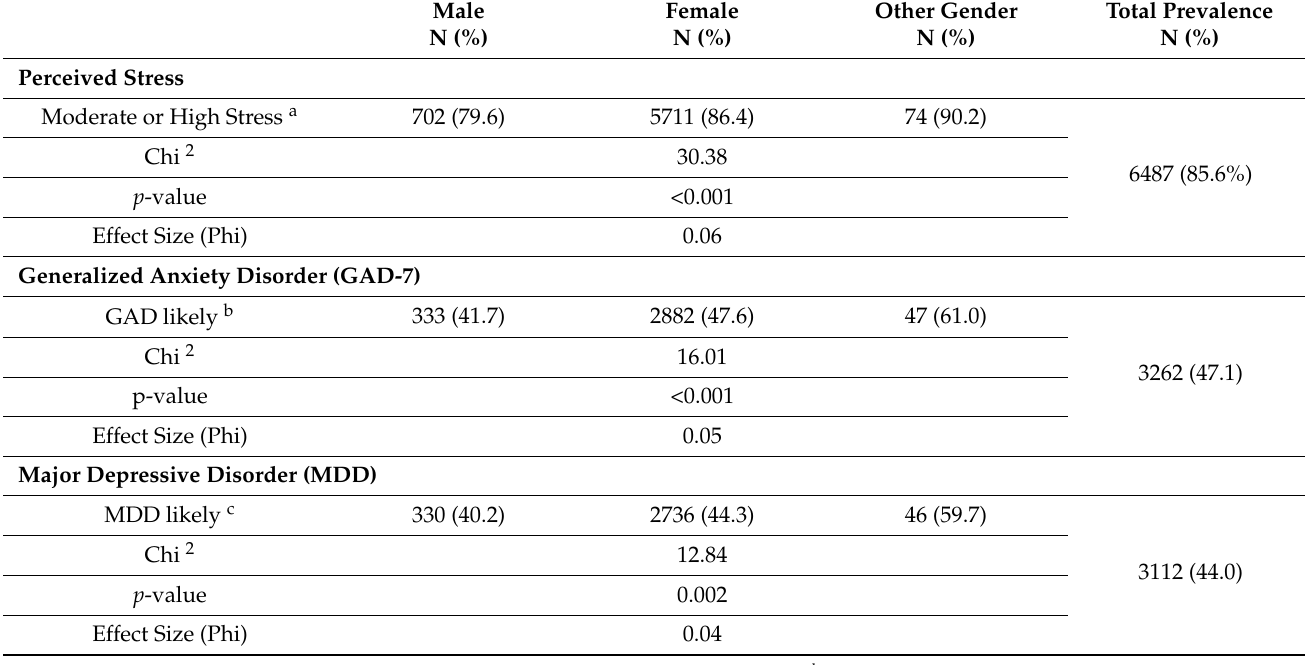
Table 2. Chi-square test of association between gender identity categories and the prevalence of perceived stress, likely generalized anxiety disorder, and likely major depressive disorder.